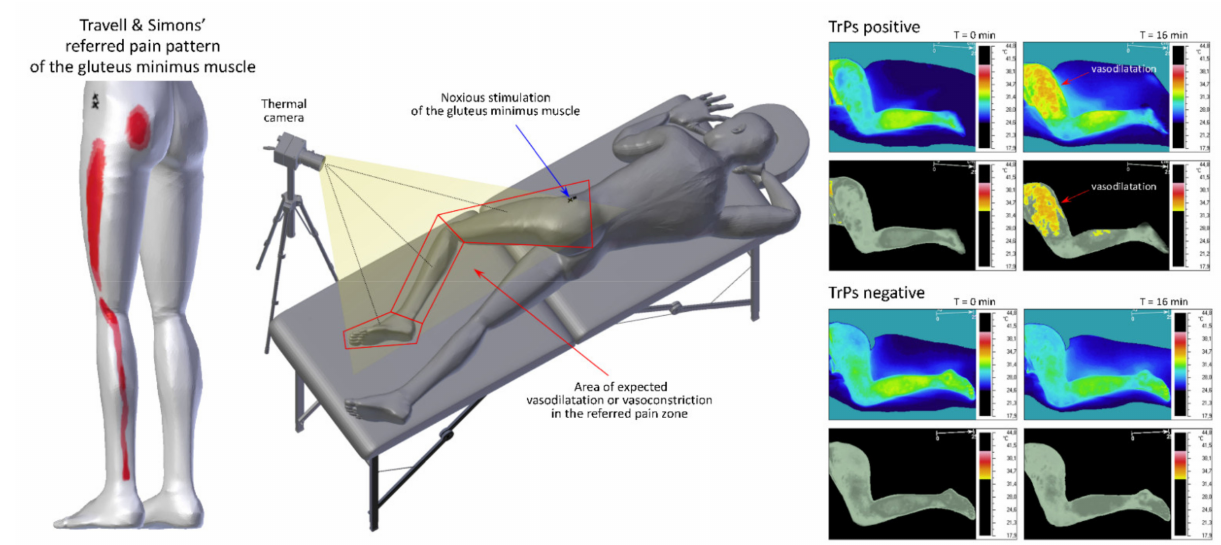
Figure 2. An illustration of the Minimally Invasive Procedure (MIP).